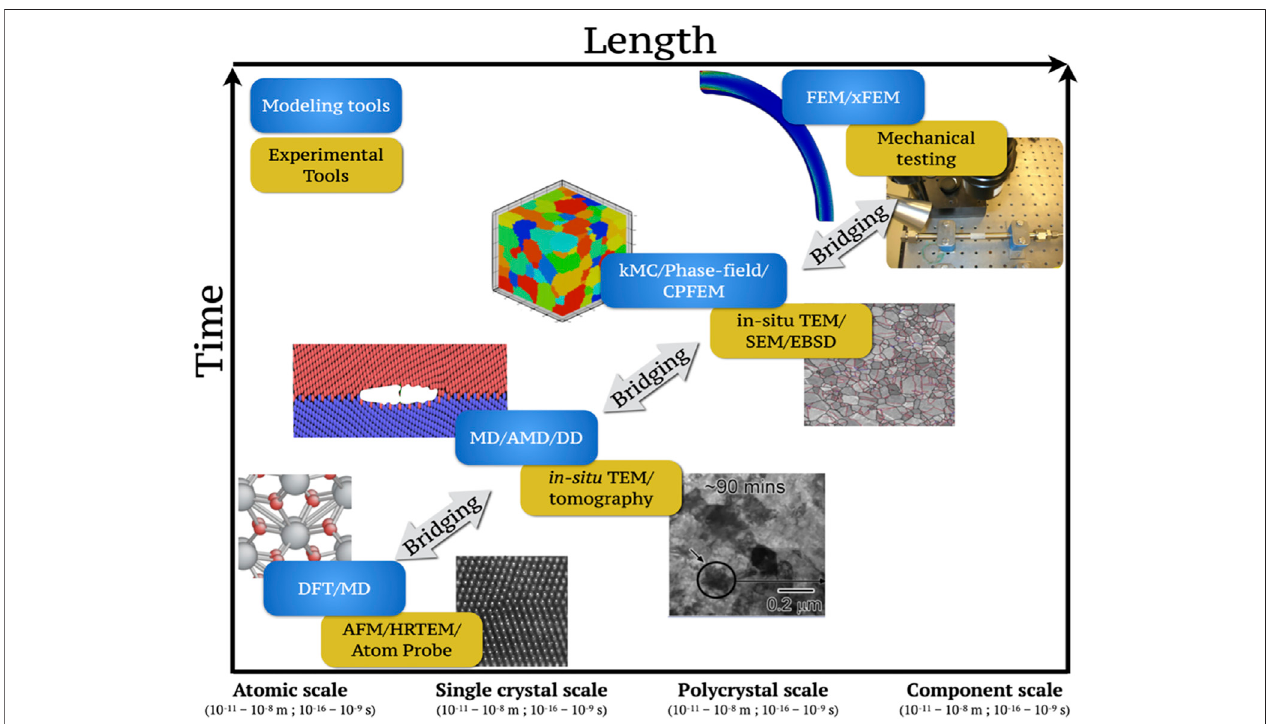
FIGURE 2 | Modeling and experimental tools typically used to obtain relevant materials data at different length and time scales. Example of modeling tools used include Density Functional Theory (DFT), Molecular Dynamics (MD), Accelerated MD (AMD), Dislocation Dynamics (DD), kinetic Monte Carlo (kMC), Crystal Plasticity Finite Element Modeling (CPFEM), FEM, and extended FEM (xFEM). Examples of experimental tools used include Atomic Force Microscopy (AFM), High Resolution Transmission Microscopy (HRTEM), in situ TEM, tomography, Scanning Electron Microscopy (SEM), Electron Backscattered Diffraction (EBSD), and mechanical